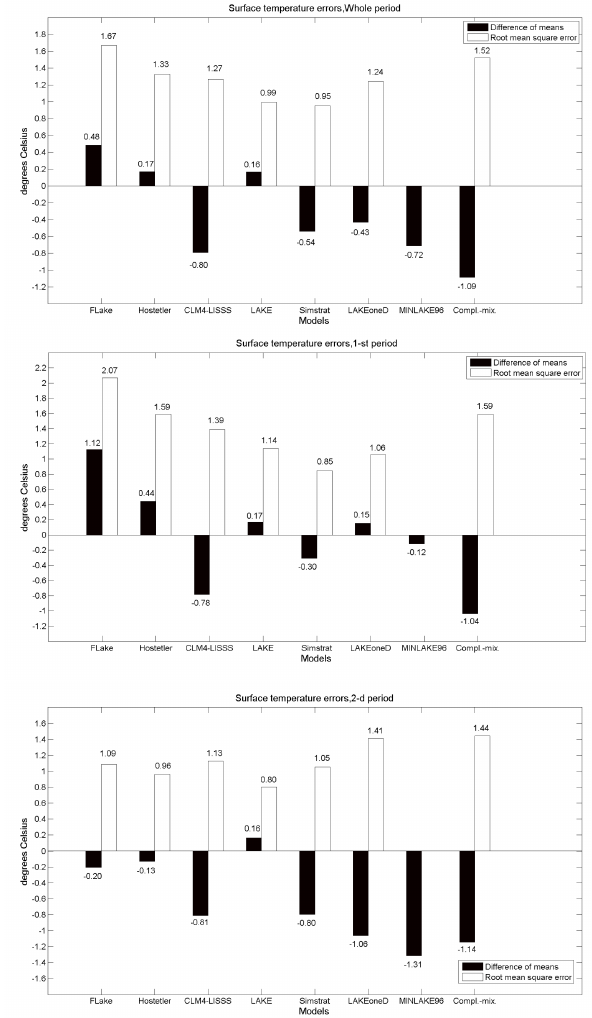
Fig. 3. Differences between modeled and observed means and mo- dels’ RMSEs of mixed-layer